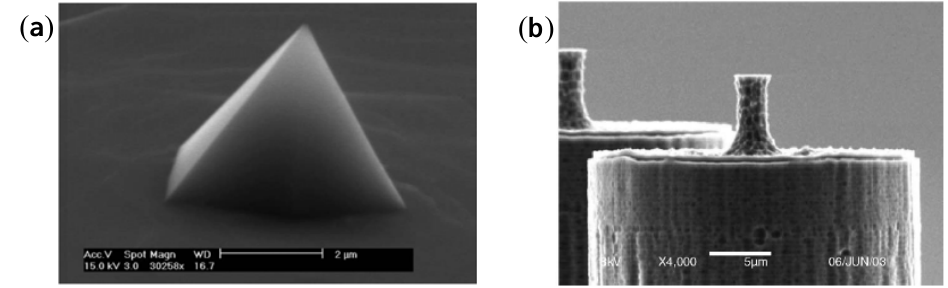
Figure 12. ( a ) SEM of cone-shaped electrodes on glass substrate. (Reprinted from [36]. ©2006, with permission from Elsevier) ( b ) SEM of cylindrical electrodes on silicon substrate. (Reprinted from [61]. © 2006, with permission from